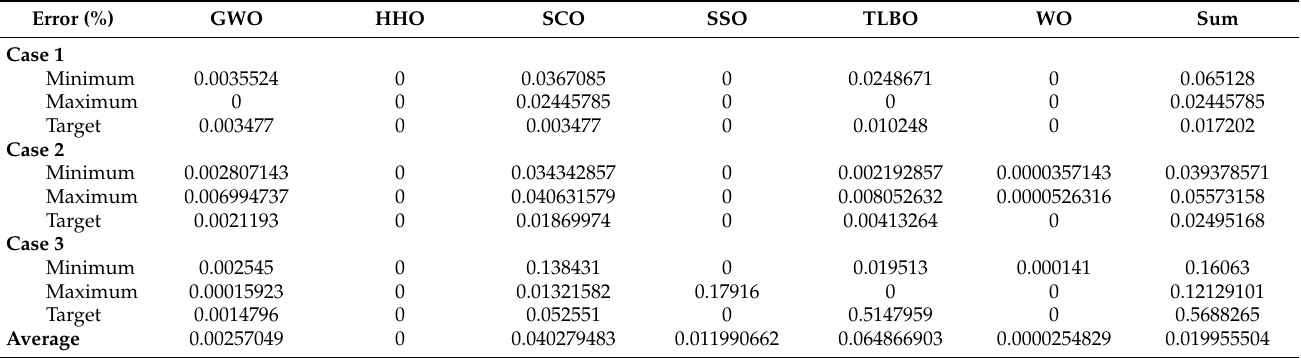
Table 5. Summary